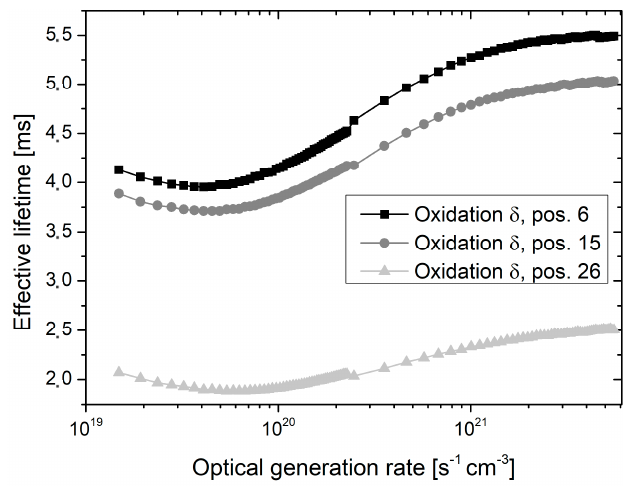
Figure 10. Effective lifetime as a function of the optical generation rate measured in the center of wafers, which were extracted from oxidation run δ and placed in quartz boat positions 6, 15, and 26, respectively. Quartz boat position 26 is located in direction of the tube door.